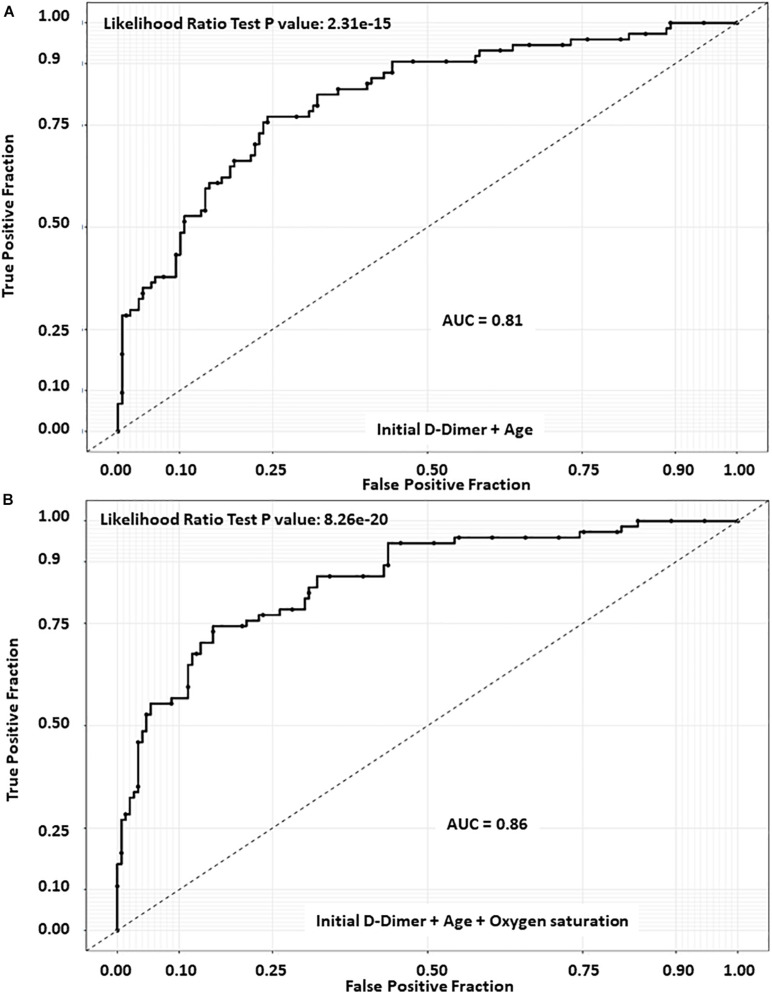
Receiver operating characteristic curve (ROC) of D-Dimer. (A) D-Dimer combined with age only displayed an AUC of 0.81. (B) D-Dimer combined with age and Oxygen saturation showed an area under the curve (AUC) of 0.86.